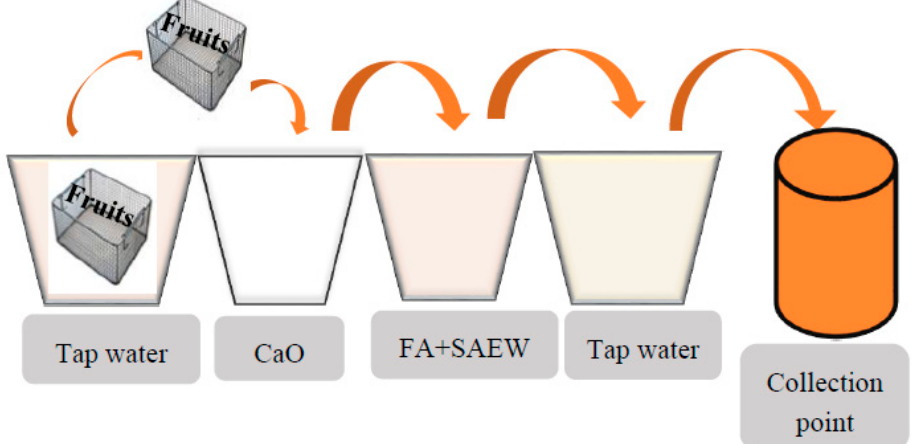
Figure 1. Industrial-scale sequential treatment line developed at Nette Company. Each kind of fruit was separated into three groups. The first group of fresh samples (2 kg) was washed in a treatment tank containing 180 L of slightly acidic electrolyzed water (SAEW) combined with 0.5% (w / v) fumaric acid (FA) (FA + SAEW) for 3 min at room temperature (RT, 23 ◦ C) and then rinsed with tap water for 1 min. For the second group, the fresh samples (2 kg) were dipped in 180 L of CaO for 3 min, and followed with the first round treatment. In the third group, samples were washed in 180 L of tap water for 5 min and this group served as control. After the treatments, autoclaved towel tissues were used to wipe o ff excess chemical solution or tap water from the surface of treated samples. The fruits were individually packed in sterile stomacher bag and transported to the laboratory under low temperature for microbiological analysis.